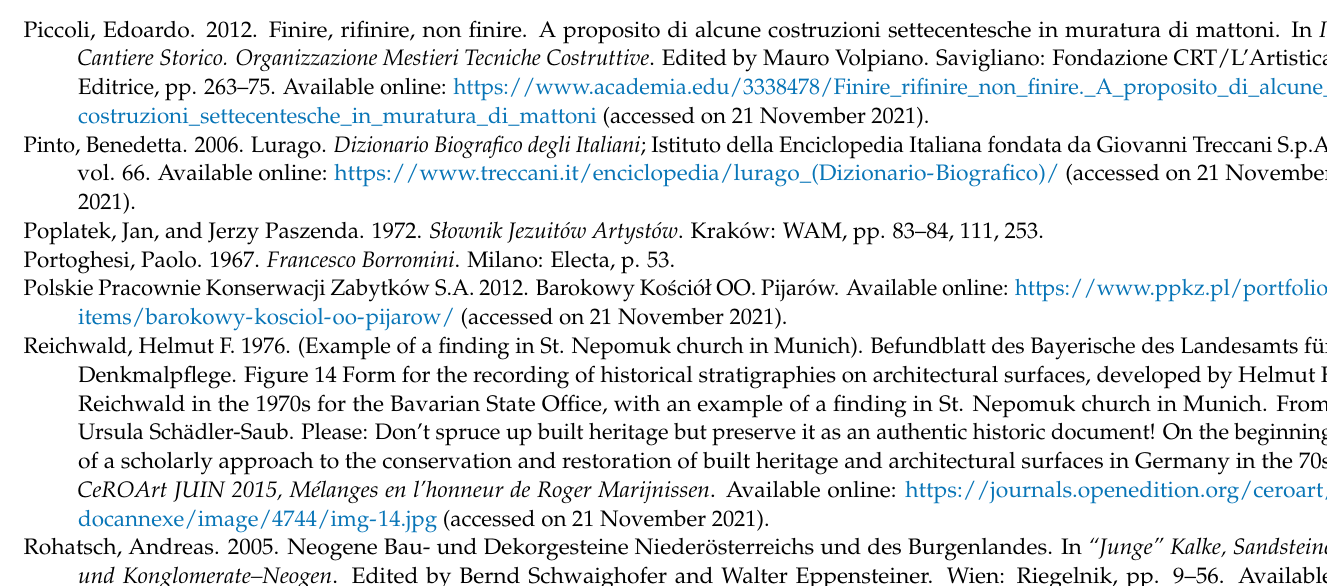
Reichwald, Helmut F. 1976. (Example of a finding in St. Nepomuk church in Munich). Befundblatt des Bayerische des Landesamts für Denkmalpflege. Figure 14 Form for the recording of historical stratigraphies on architectural surfaces, developed by Helmut F. Reichwald in the 1970s for the Bavarian State Office, with an example of a finding in St. Nepomuk church in Munich. From: Ursula Schädler-Saub. Please: Don’t spruce up built heritage but preserve it as an authentic historic document! On the beginning of a scholarly approach to the conservation and restoration of built heritage and architectural surfaces in Germany in the